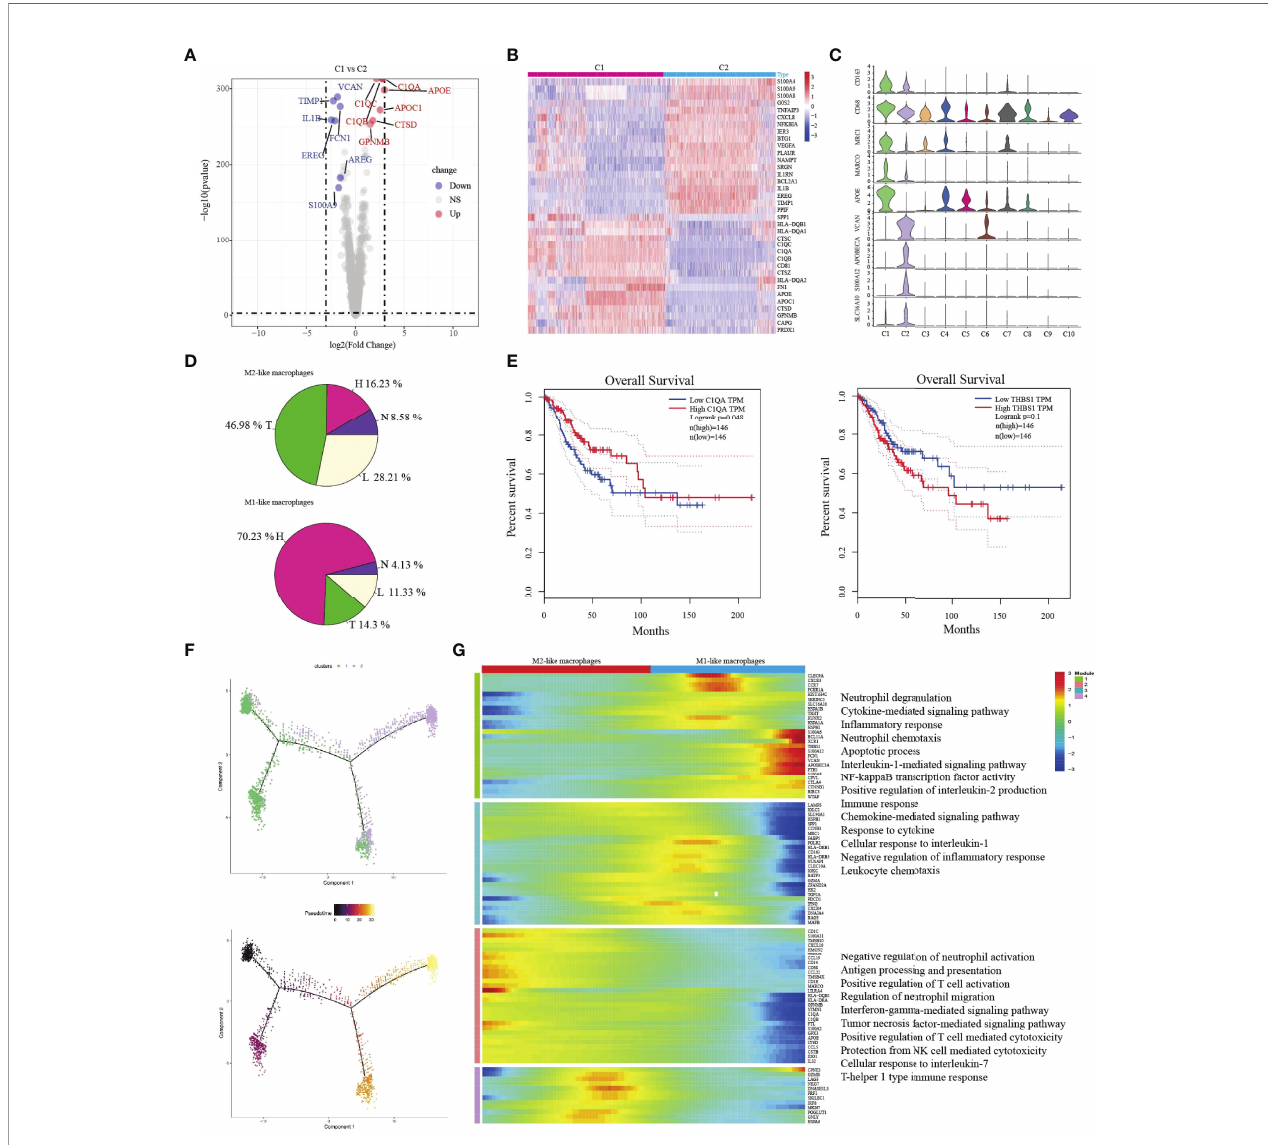
FIGURE 5 | The transition of two types of macrophages during tumor progression. Volcano plot showing the top differently genes between two types of macrophages (A) . Heatmap indicating differently genes between two types of macrophages (B) . Violin plots showing the distribution module score for selected genes for each cluster. Error bars indicated the means ± SD (C) . Pie graph showing the proportions of cells among four groups (D) . Kaplan – Meier curve showing survival of C1QA, and THBS1 genes in TCGA-SCC patients (E) . Trajectory of both two macrophage clusters along pseudotime in a two-dimensional state-space de fi ned by Monocle2. Each point corresponds to a single cell, and each color represents a macrophage cluster (F) . Heatmap indicating the differentially expressed genes (rows) along the pseudotime (G)